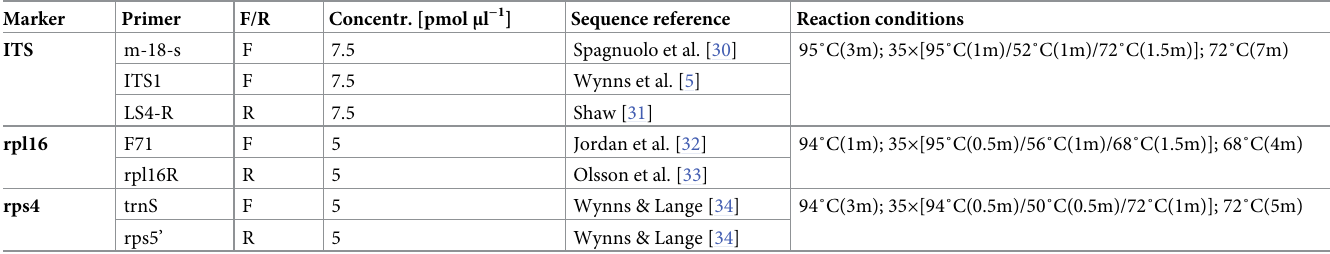
Table 2. Primers used for amplification and sequencing with PCR reaction